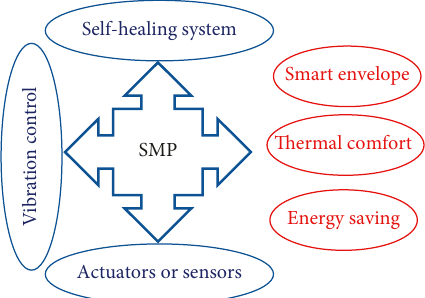
Figure 6: Applications of SMPs in civil and architectural